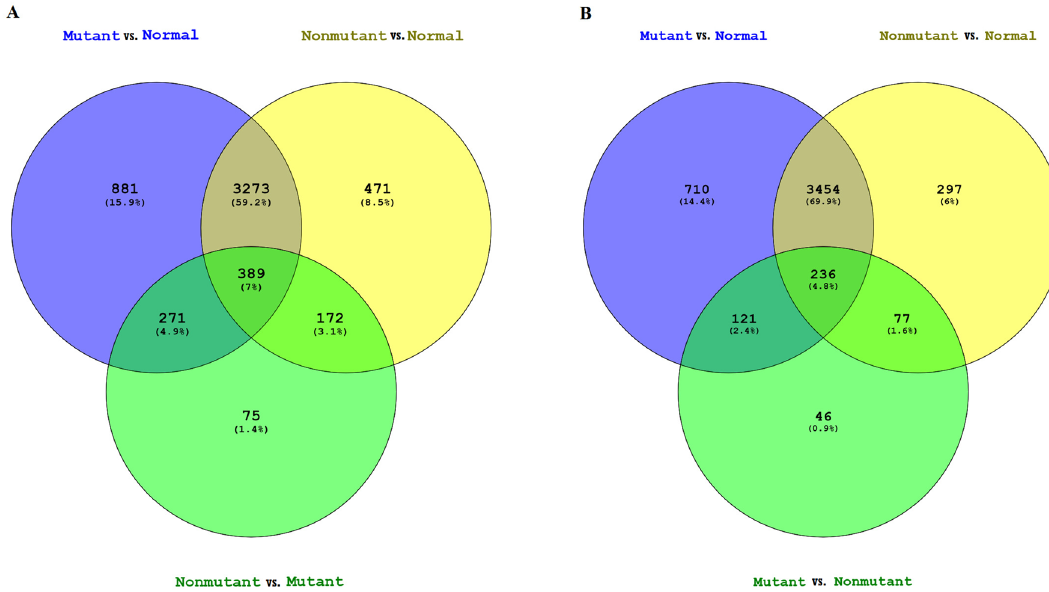
Figure2. Venn diagram indicating differentially expressed genes overlapping between the samples in ( A ) the entire patient and ( B ) ER-positive subgroup. Blue: GATA3 -Mutant versus Normal; Yellow: GATA3 -Non-mutant versus Normal; Green: GATA3 -Mutant versus Non-mutant.